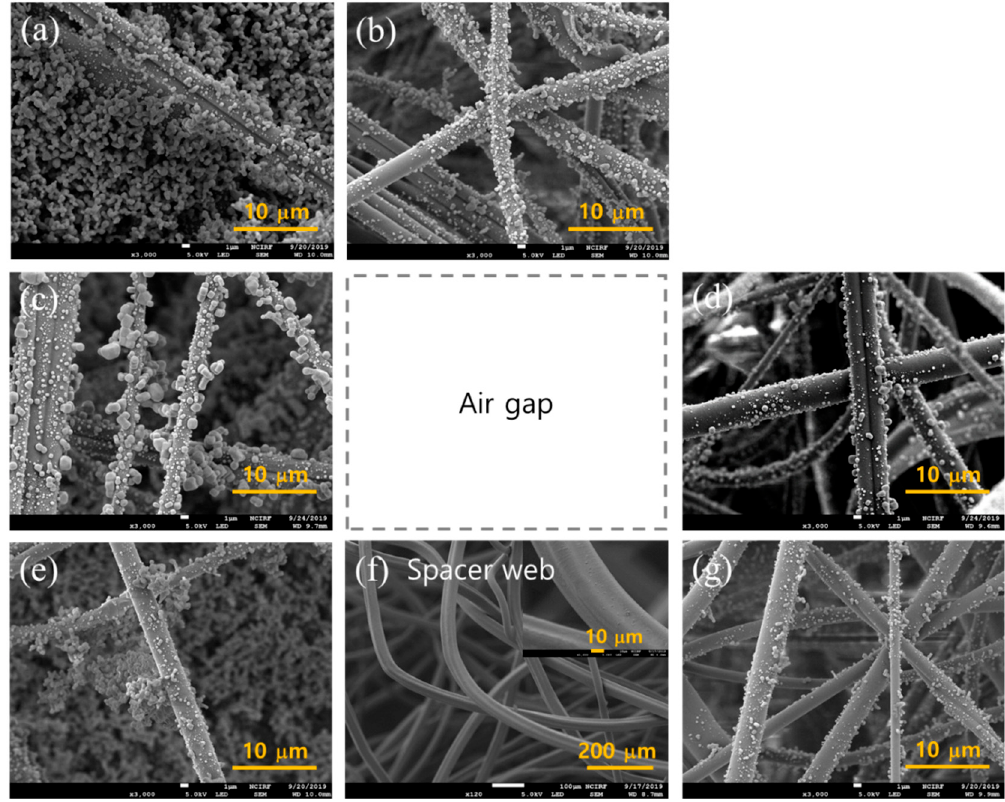
Figure 8. SEM images of 2-layer construction after 30 mg loading (15 cm/s). ( a ) 1st MB layer with 0 gap, ( b ) 2nd MB layer with 0 gap, ( c ) 1st MB layer with air gap, ( d ) 2nd MB layer with air gap, ( e ) 1st MB layer with S gap, ( f ) S web inserted between MB layers, ( g ) 2nd MB layer with S gap.